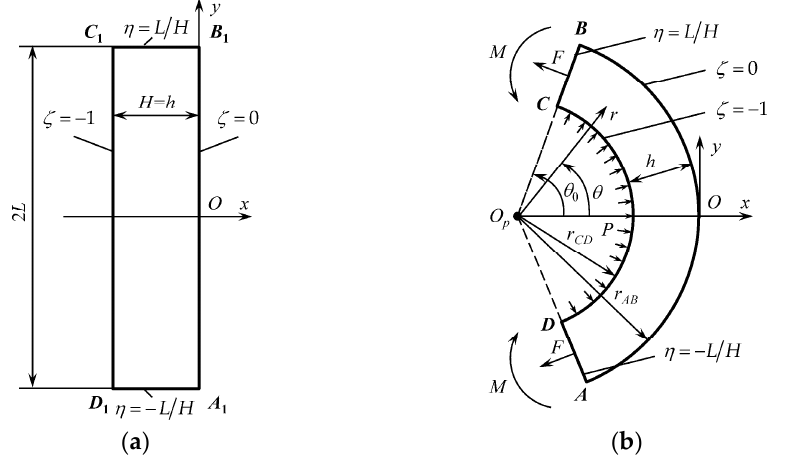
Figure 1. Schematic diagram of the bending process: ( a ) initial configuration and ( b ) intermediate and final configurations.